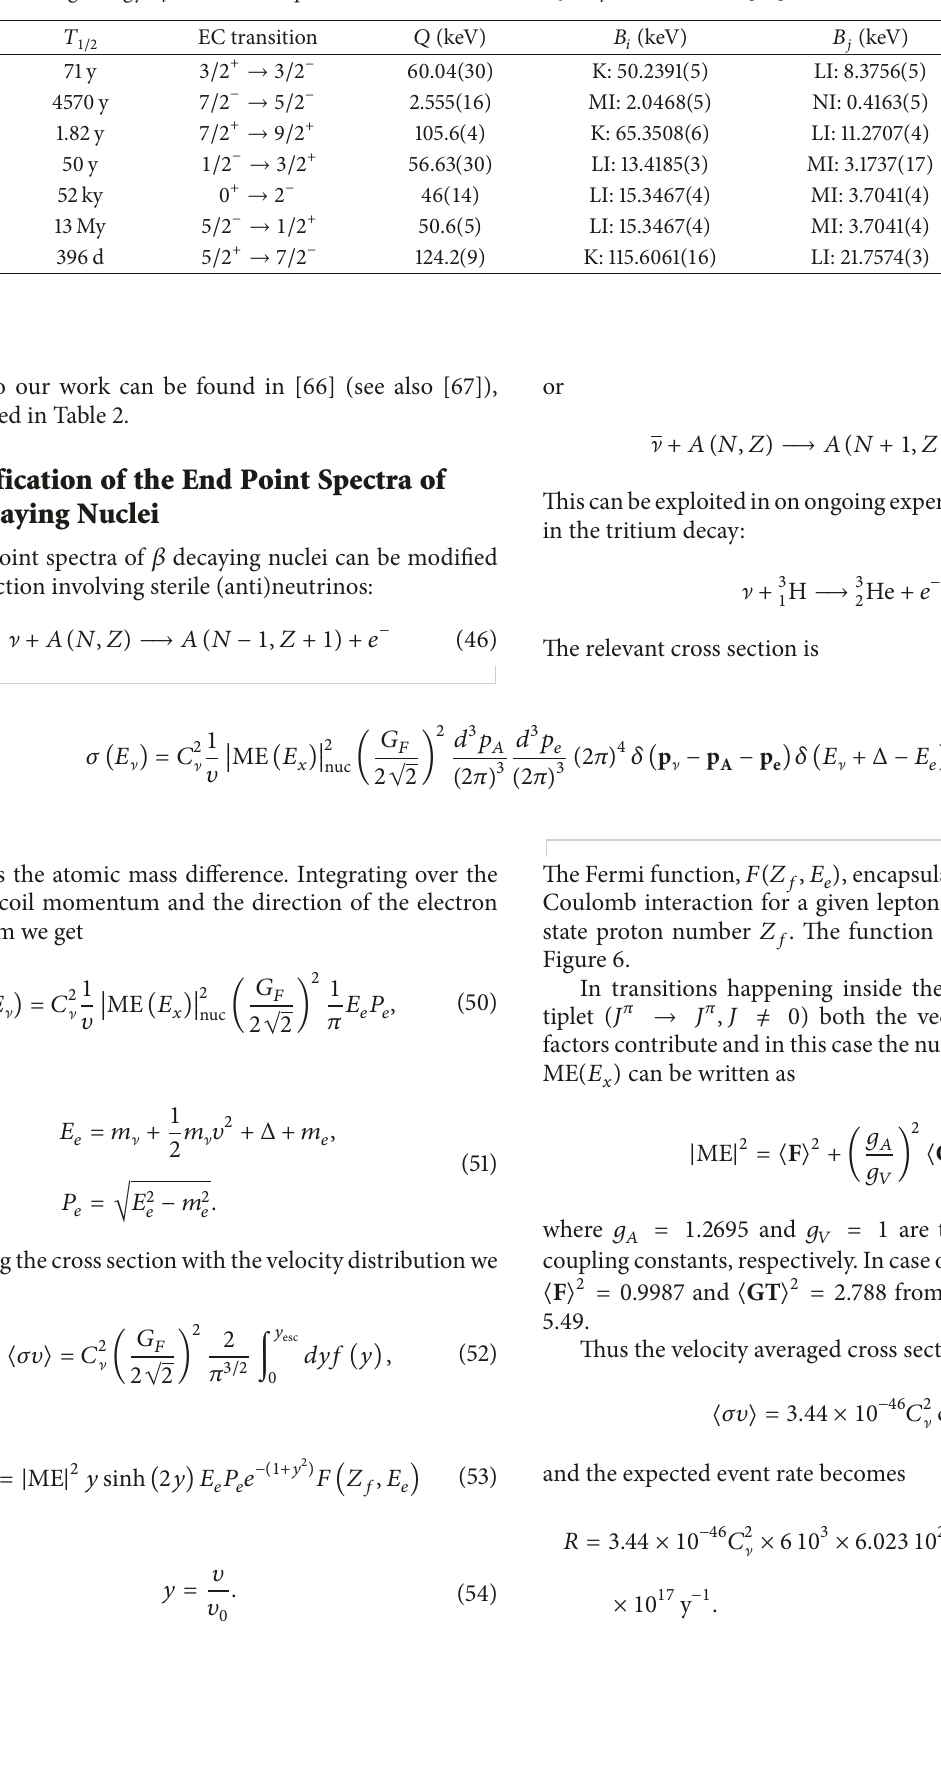
Table 2: Nuclides relevant for the search of the keV sterile neutrinos in the electron capture process. We give the life time 𝑇 1/2 , the 𝑄 -value, the electron binding energy 𝐵 𝑖 for various captures, and the value of Δ = 𝑄 − 𝐵 𝑖 . For details see